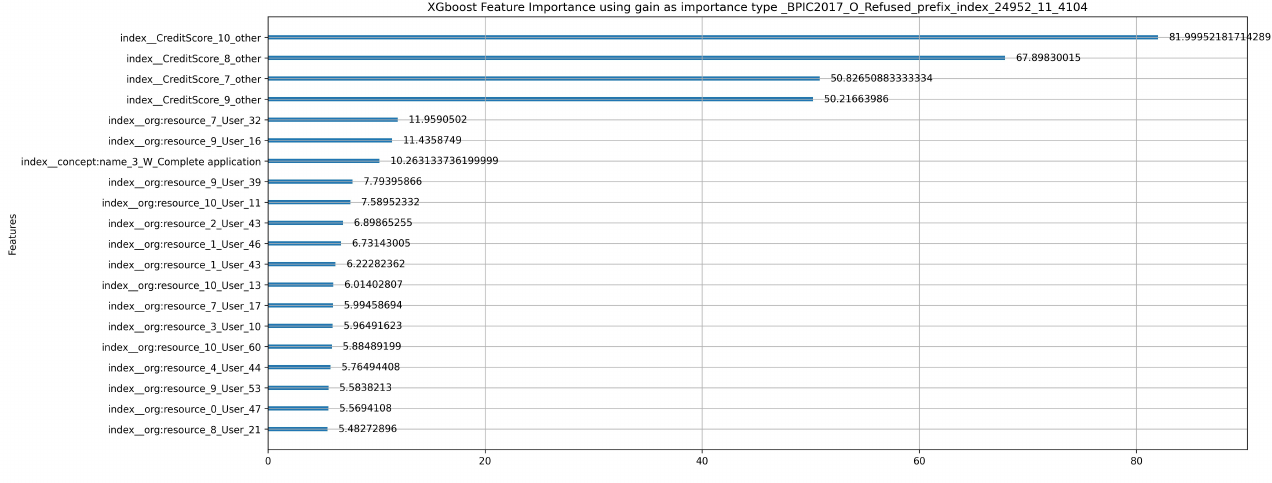
Figure 8. XGBoost features importance (gain) for prefix length (11) of BPIC2017_Refused